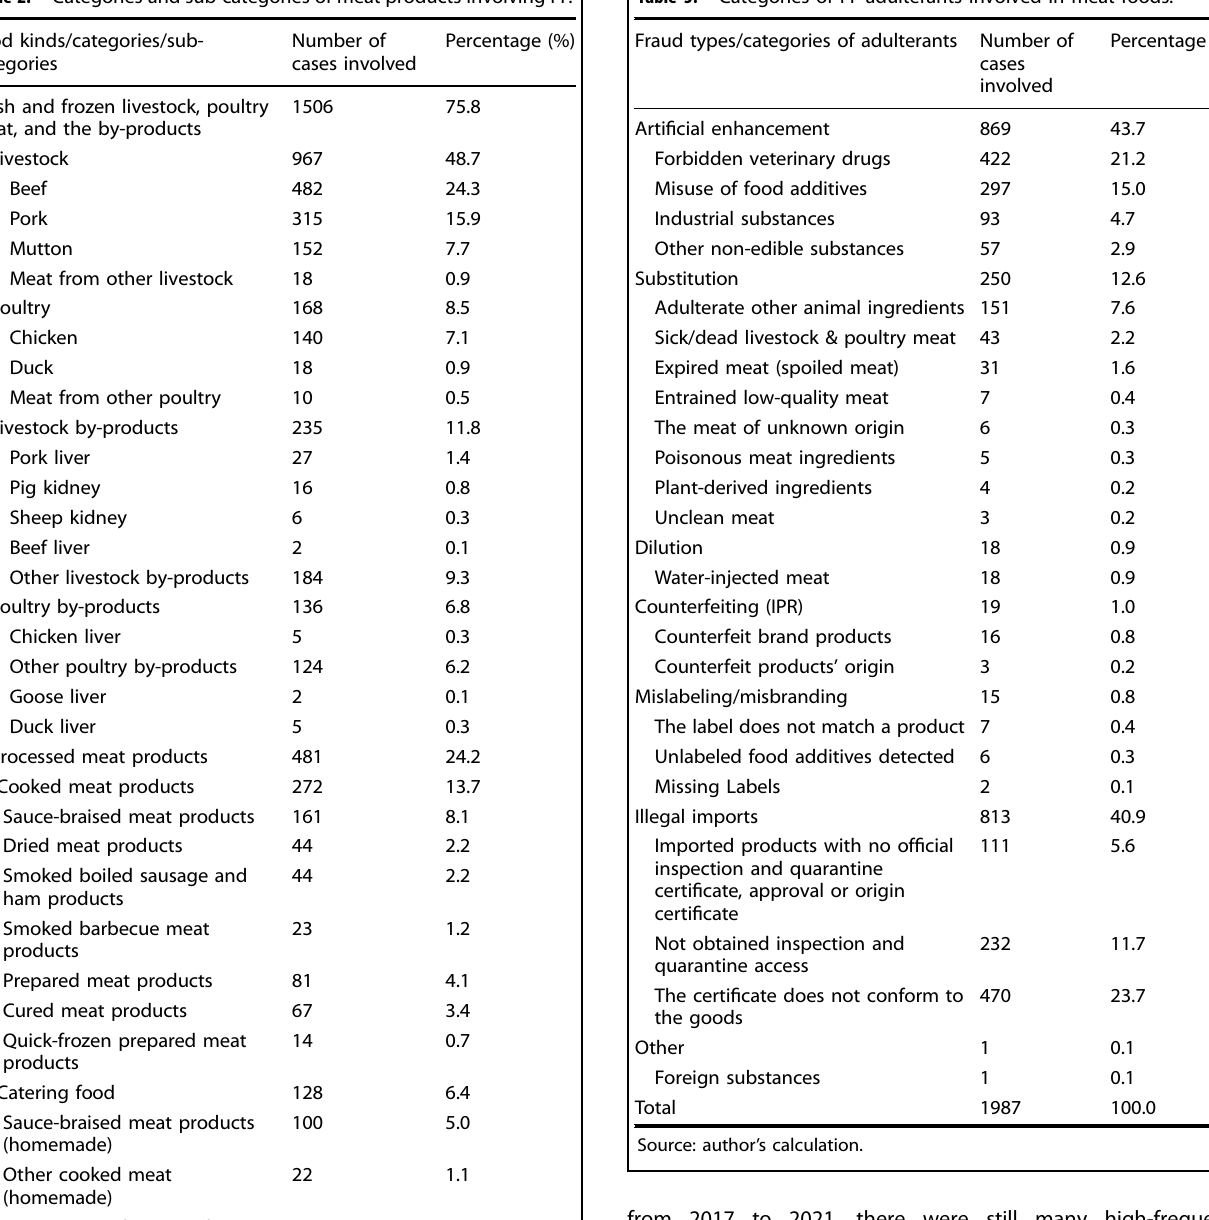
Table 2. Categories and sub-categories of meat products involving FF. Table 3. Categories of FF adulterants involved in meat